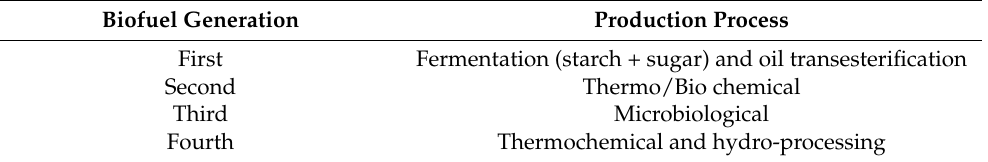
Table 2. Types of